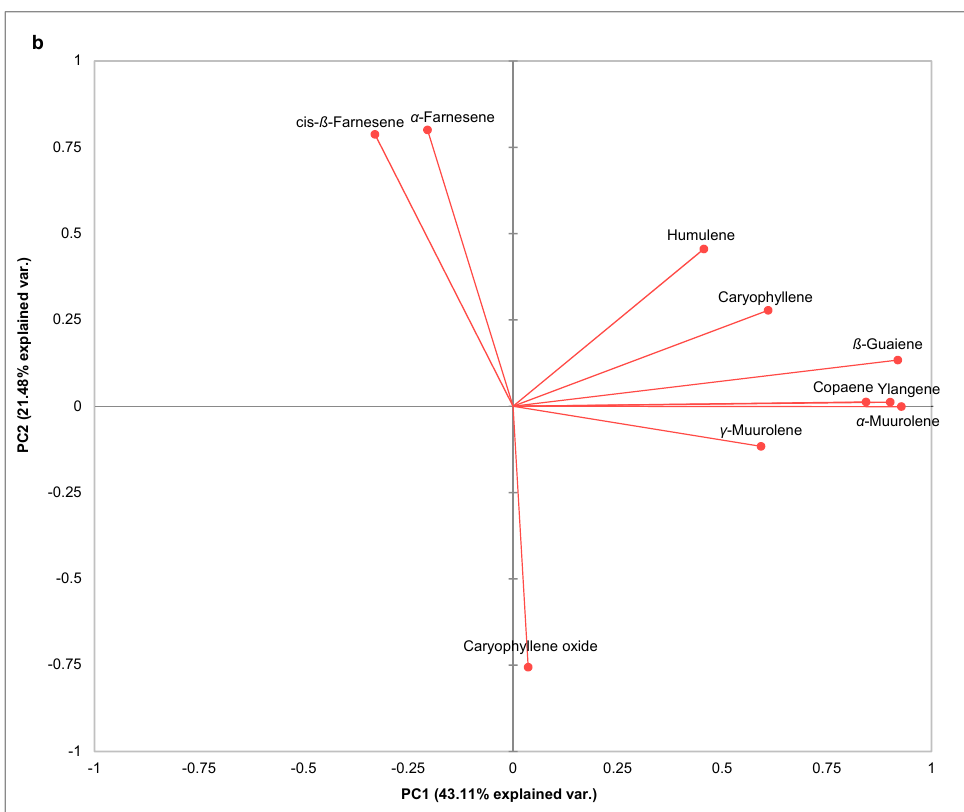
Figure 2. PCA scatter plot depicting ( a ) OIV classes of resistance (1, 3, 5, 7, and 9 from the most susceptible to totally resistant) based on their leaves’ sesquiterpenes absolute peak area before and after artificial P. viticola inoculation at 0, 24, 48 and 96 hpi in the space defined by the first two principal components explaining 64.59% of the variability; ( b ) the vector diagram of correlation among the absolute peak area of sesquiterpenes and the first two principal components.